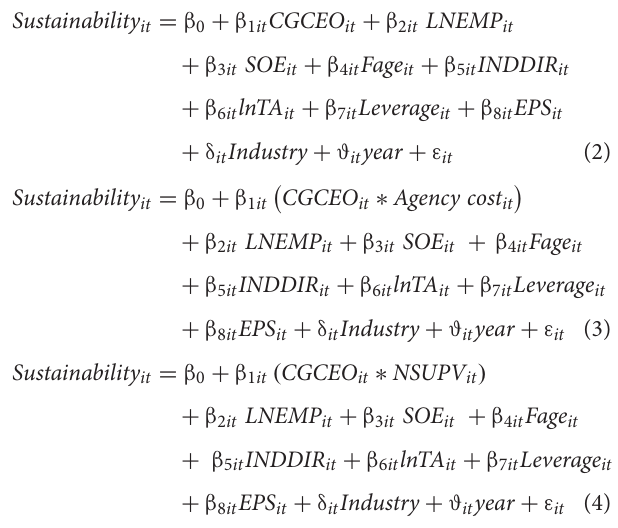
variables. The maximum correlation values are “0.4437” and “0.4329,” while the remaining correlation values are